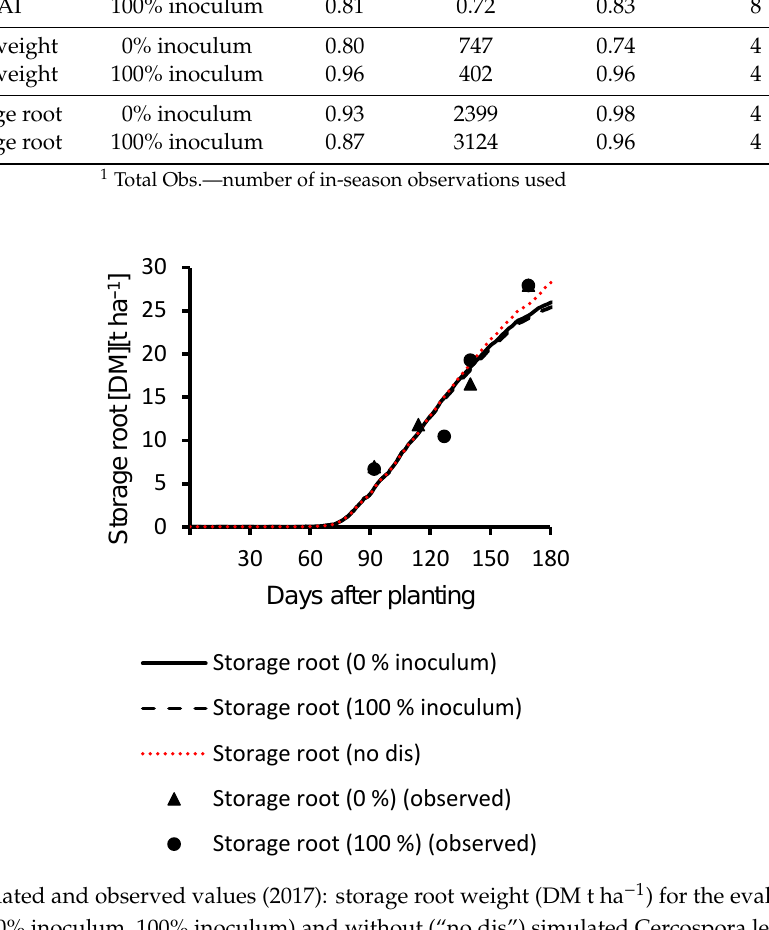
Table 7. Detailed statistics for simulated and observed values of LAI (m 2 m −2 ), top weight (DM) kg ha −1 , and storage root weight (DM) kg ha −1 for the evaluation treatments 0% and 100% inoculum in 2018.